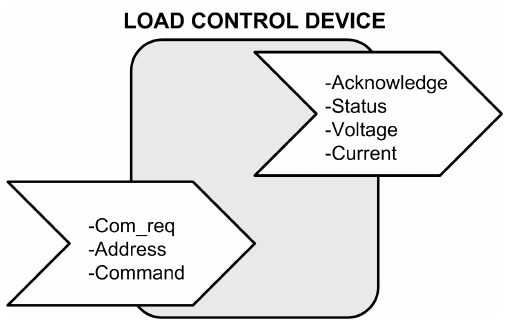
Figure 5. Load control device network input and output